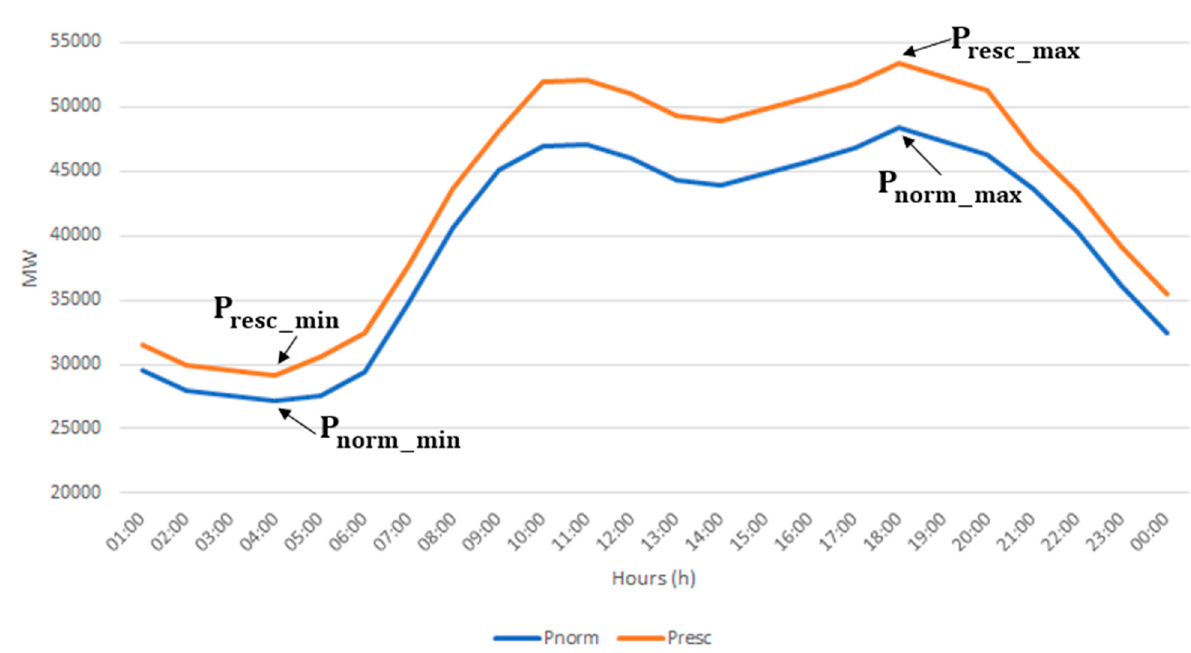
Figure 3. Stretch rescaling of a daily demand profile.